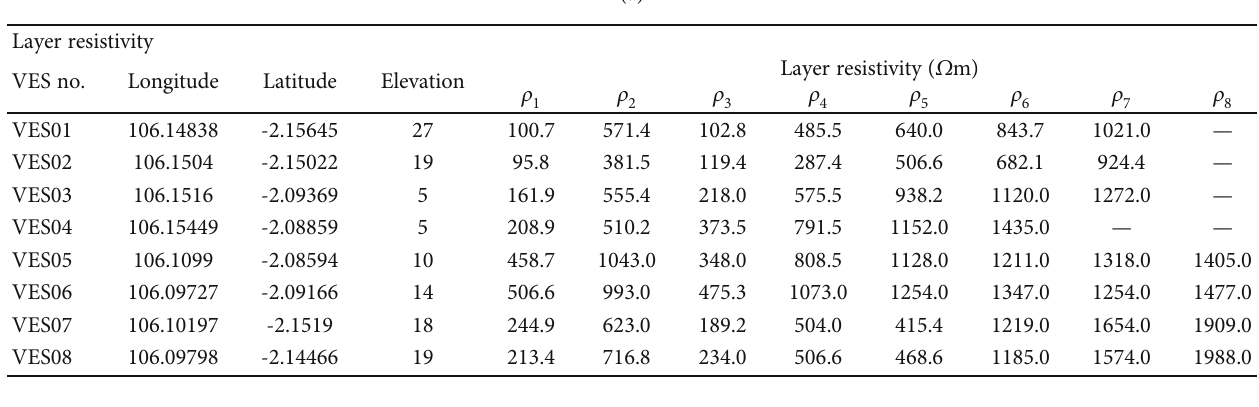
Table 7: Summary of vertical electrical sounding inversion result.